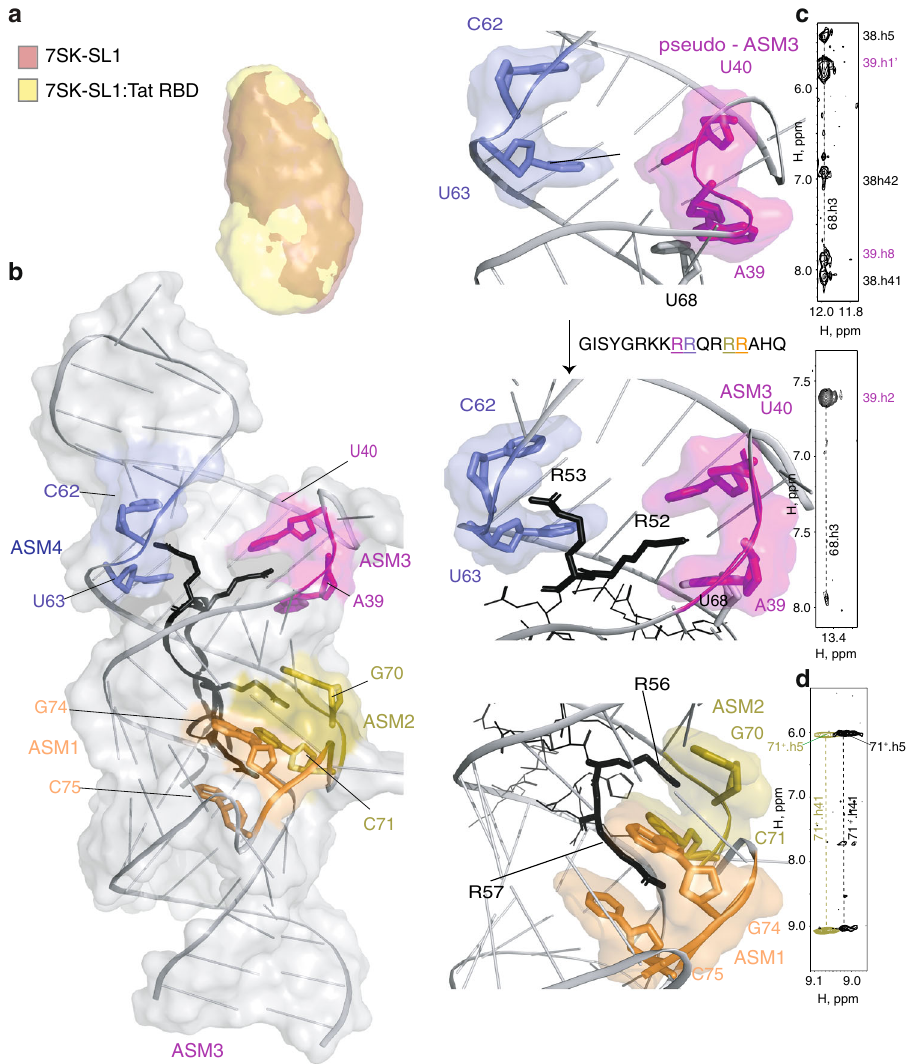
Fig. 2 Structure and characterization of Tat RBD bound to 7SK-SL1 apical . a Overlay of reconstructed ab initio SAXS envelope of free 7SK-SL1 apical (coral) and the 7SK-SL1 apical :Tat RBD complex (yellow) demonstrating the lack of global rearrangement of the RNA. b NMR structure of 7SK-SL1 apical bound to Tat RBD (black), showing multiple arginines intercalating into the ASMs. Arginine residues in the Tat RBD primary sequence are color-coded to match the respective ASMs that they intercalate into. Top and middle insets: R52 induces the formation of ASM 3 from the pseudo-ASM 3 con fi guration, while R53 interacts with the preformed ASM 4 . Bottom inset: interaction of the tandem ASM 1 and ASM 2 with R57 and R56, respectively. c 1 H – 1 H two- dimensional NOESY showing transition of A 39 -U 68 from a reverse Hoogsteen interaction to a Watson-Crick interaction by the appearance of the characteristic U 68 imino to A 39 H2 upon titration of Tat. d Spectral overlay showing that ASM 2 remains intact after Tat intercalation as evidenced by the maintenance of the down fi eld shifted amino of the protonated cap C 71 + . Black, free 7SK-SL1 apical and olive, after titration with 1.0 equivalent of Tat